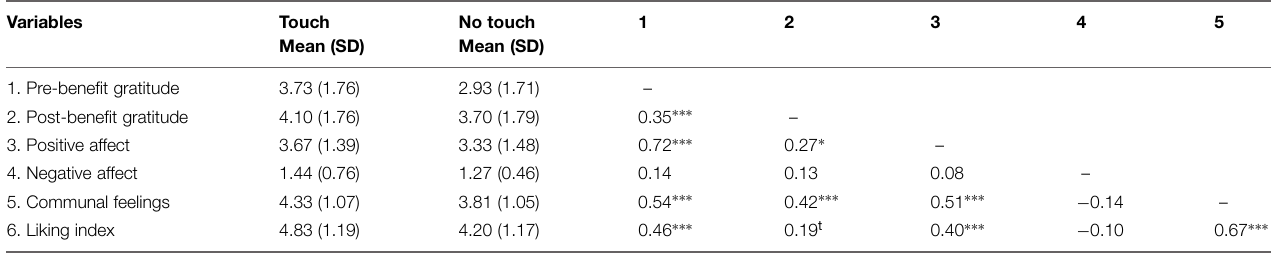
TABLE 2 | Means and SD as a function of touch, and correlations of pre- and post-benefit gratitude, positive and negative affect, communal feelings, and liking indices of Study 2 ( N = 84).